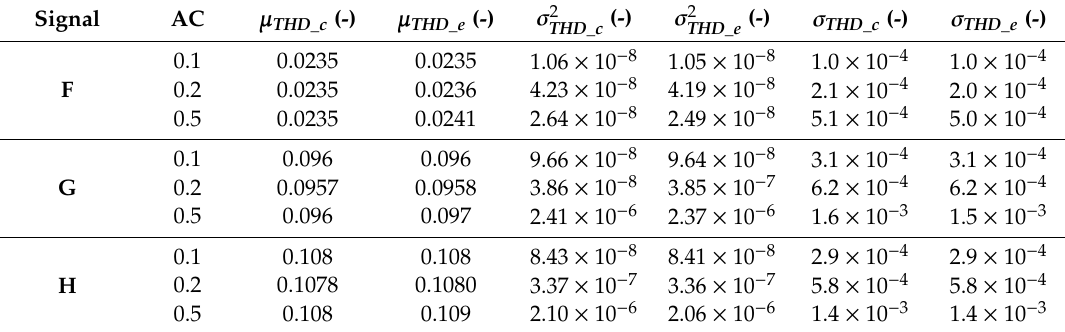
Table 3. Results of the validation test, which involves three signals and 3 accuracy classes. Signal